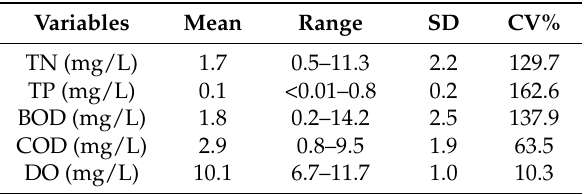
Figure 2. Location of the selected 30 river basins in Japan. Table 2. Statistical parameters of the studied water quality variables (SD means standard deviation; CV means coefficient of variation).